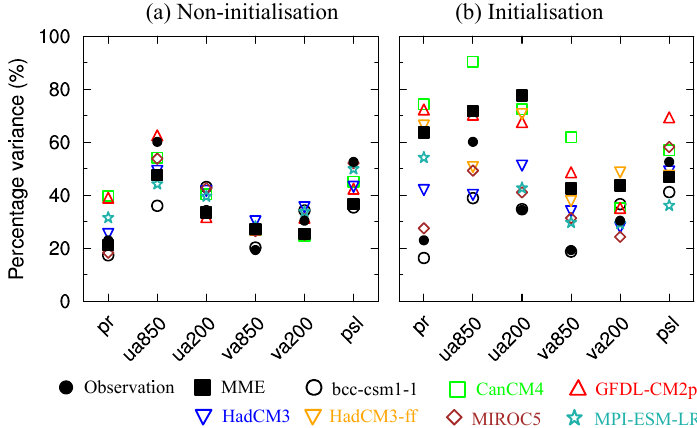
Figure 6. Fraction of variance (%) explained by the first EOF mode for six fields in the non-initialisation (a) and the initialisation (b) .